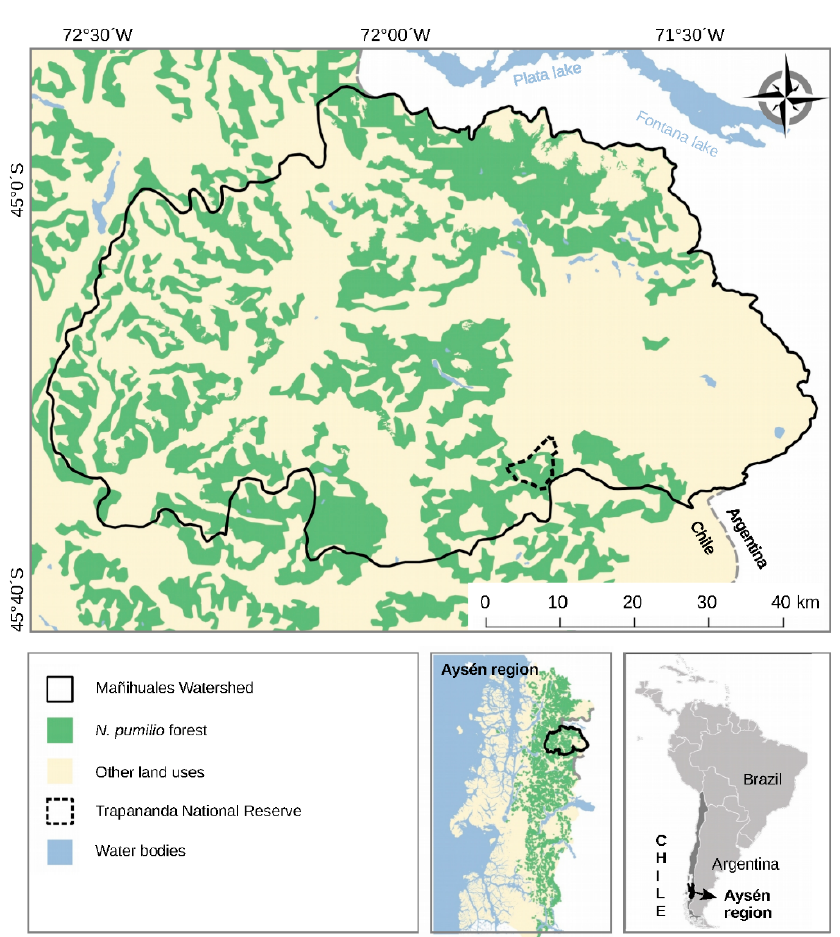
Figure 2. Study area corresponding to the Mañihuales watershed in the Aysén Region, Chilean Patagonia. The Trapananda National Reserve, the area where the validation campaign took place, is demarcated by a segmented black line. Land cover source: CONAF [38] .